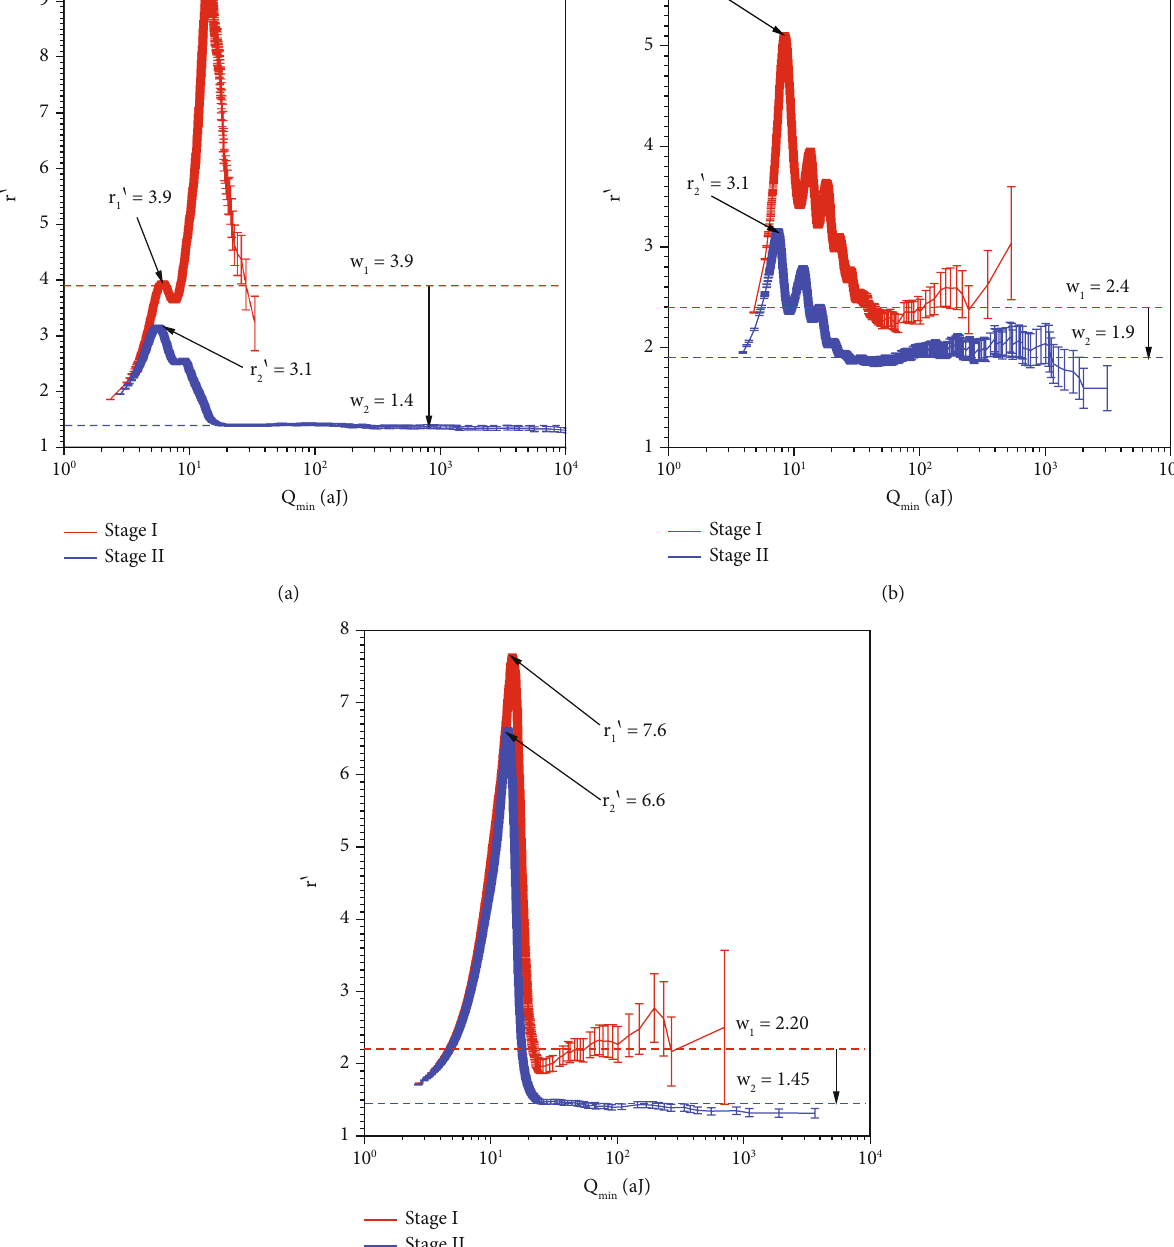
: (a) A-1, (b) B-1, and (c) C-1. The error bars at each data point min